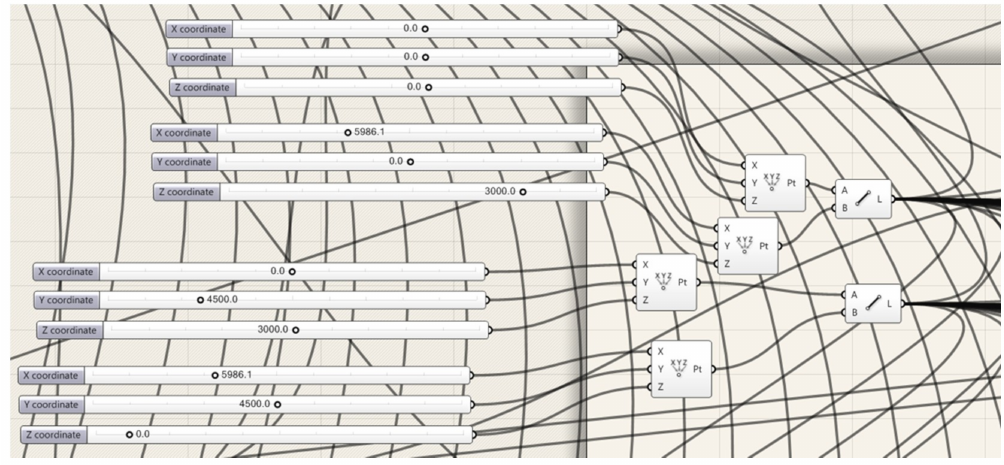
Figure 19. Four triad of sliders that allow three coordinates of the ends of two directrices, e and f , to be